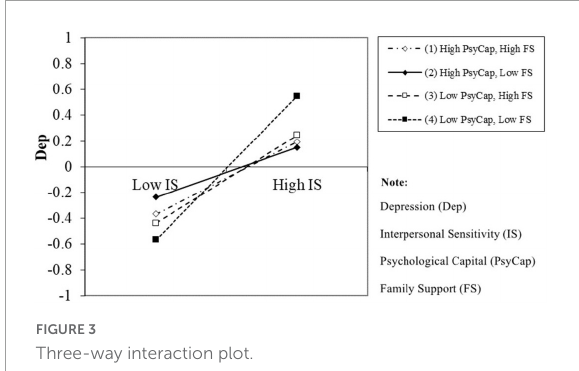
FIGURE3 Three-way interaction plot.